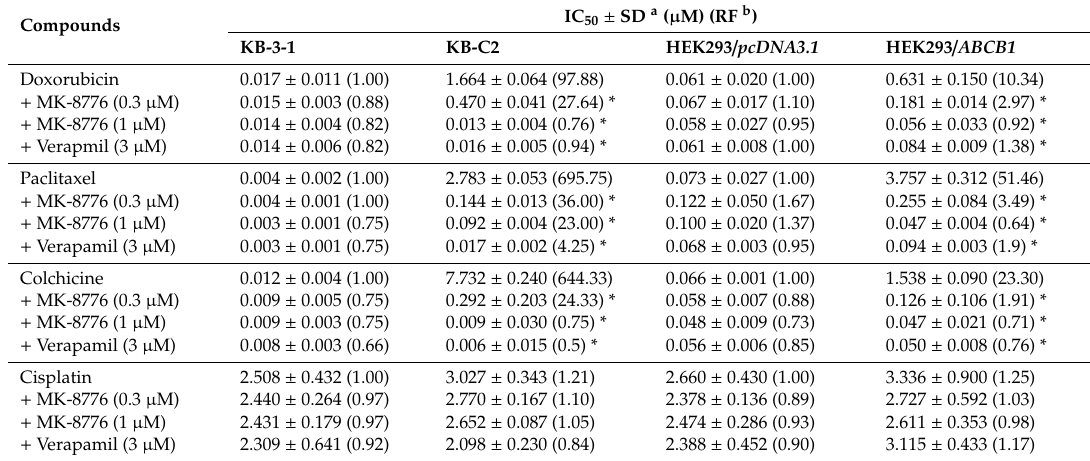
Table 1. MK-8776-sensitized doxorubicin, paclitaxel, and colchicine in KB-C2 and HEK293 / ABCB1 cells. Compounds